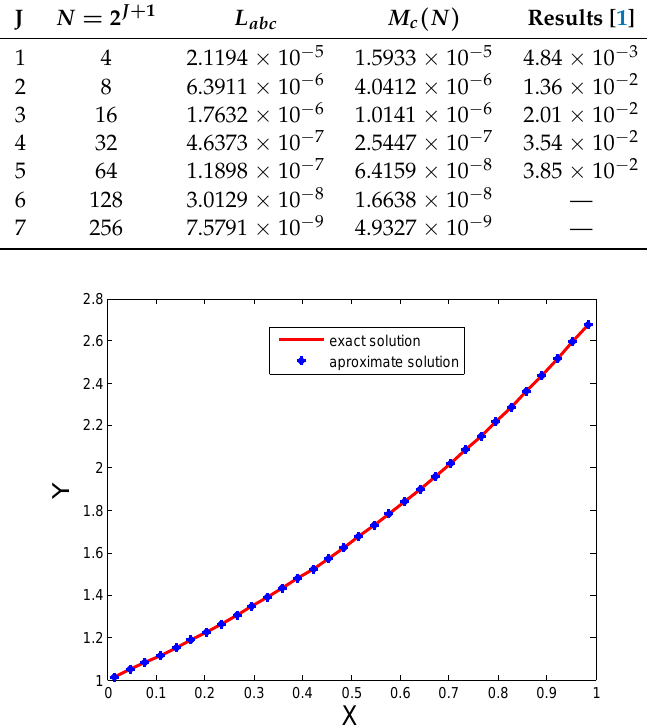
Figure 1. Comparison of both solutions for N = 32 for Test Problem